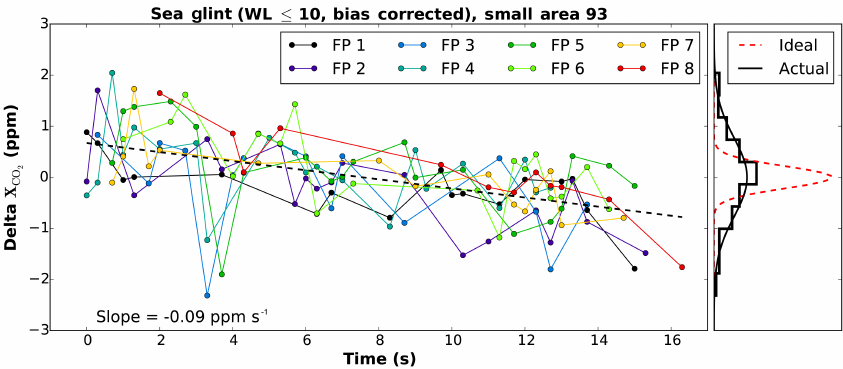
Figure 6. The difference between XCO 2 and the mean value (or delta XCO 2 ) for one of the small neighborhoods (or areas) used in this analysis. The left panel shows the differences for each footprint (FP), representative of one of the OCO-2 observations. The right panel shows the observed distribution (actual) and one calculated if the distributions were representative of the calculated random error.